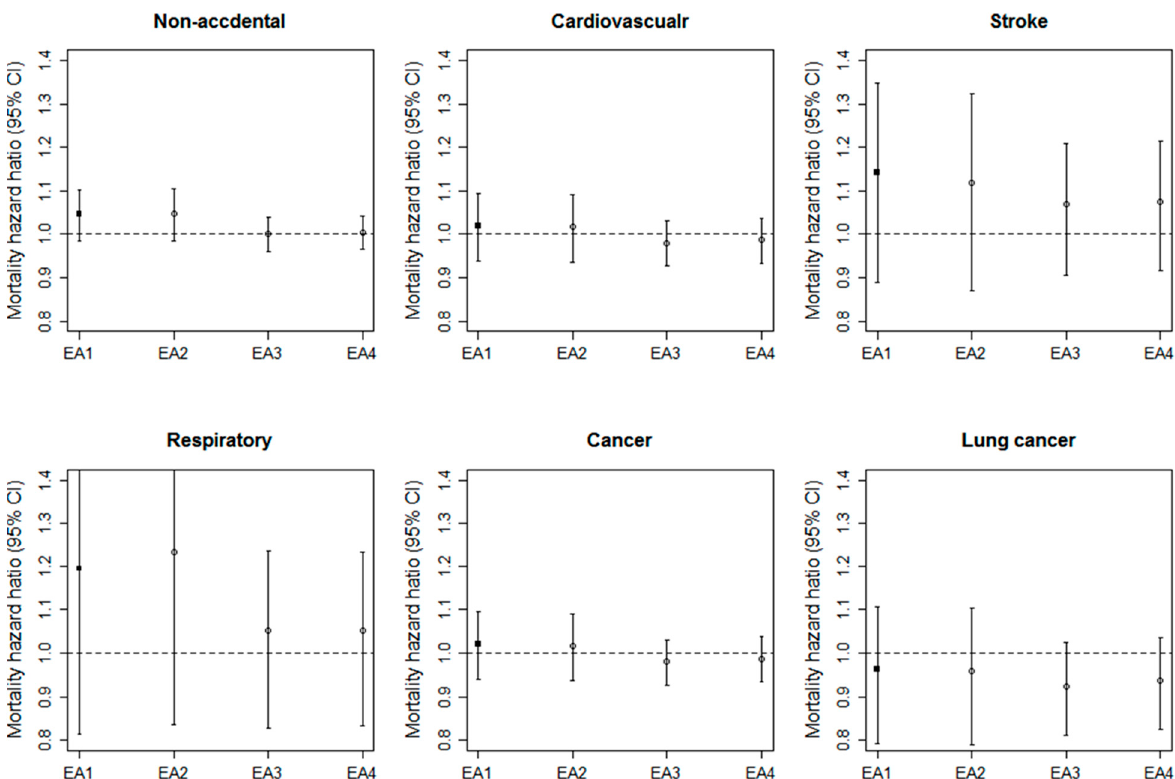
Figure 1. Hazard ratios (HRs) and 95% confidence intervals (CIs) of non-accidental and cause-specific mortality for an increase of 10 µ g/m 3 in the long-term PM 10 concentration defined by four different exposure assessment (EA) approaches after adjusting for sex, age, income, smoking, alcohol use, obese, exercise, and co-morbidity of cardiovascular disease, cerebrovascular disease, and diabetes, district-level percent of high school education completed or more, percent of the elderly, and gross regional domestic product [EA1: prediction and address in each year, EA2: prediction in each year and address at baseline, EA3: prediction at baseline and address in each year, EA4: prediction and address at baseline].